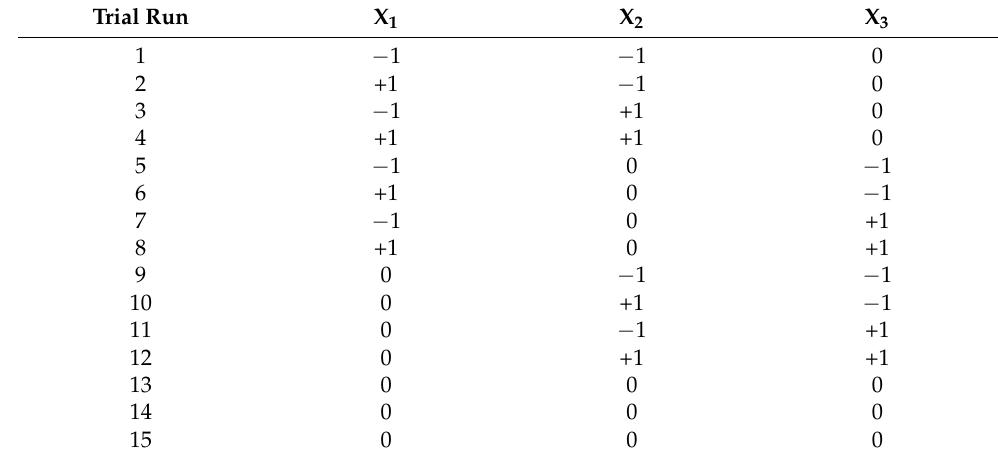
Table 2. The three-factor three-level BBD